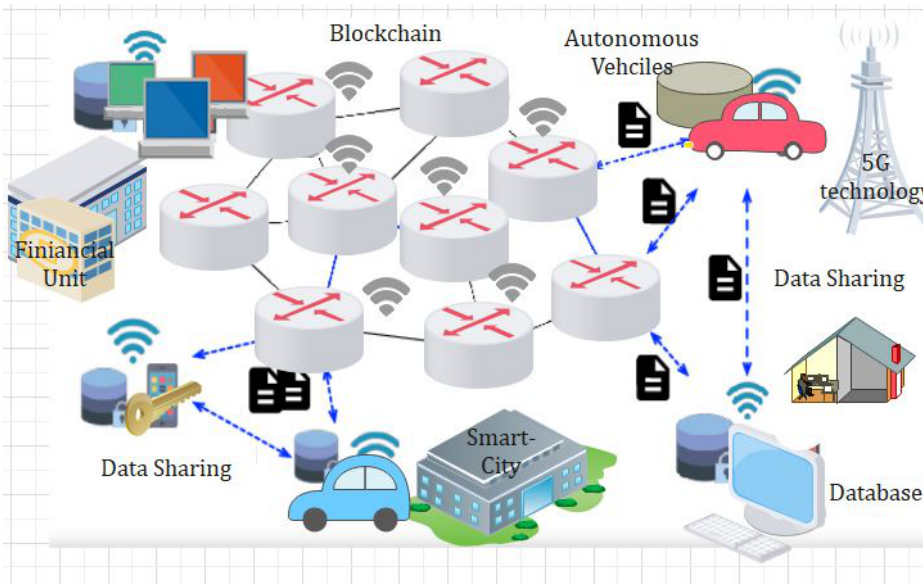
Figure 3. Proposed data-sharing